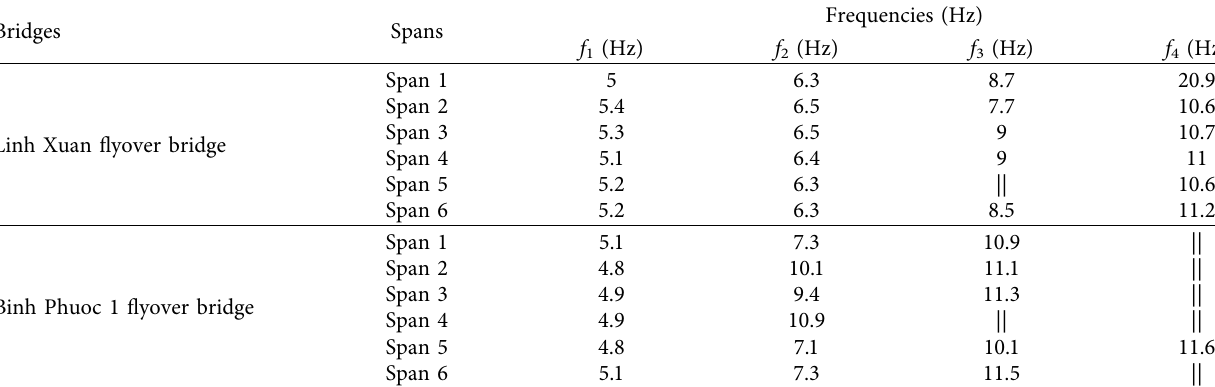
Table 14: Natural frequency values of some spans of flyover bridges.